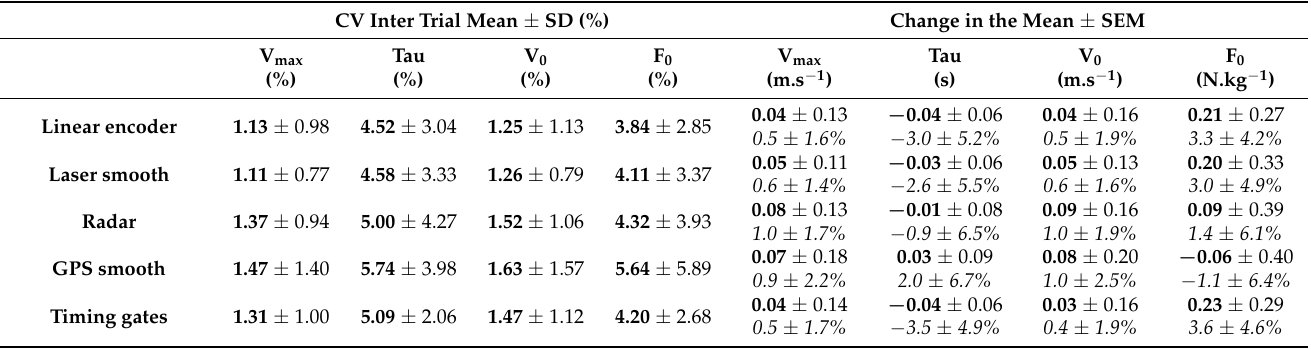
Table 3. The inter-trial coefficient of variation mean in bold (CV in %) and associated change in the mean (bold) and standard error of measurement (SEM) for all subjects and trials (n = 36) for the five systems compared. Relative change in the mean and relative SEM in % and italic. CV Inter Trial Mean ± SD